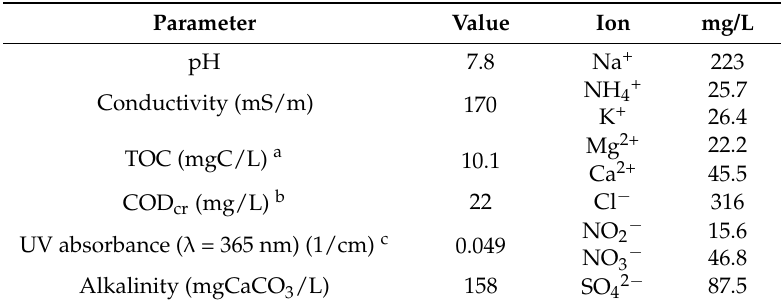
Table 1. Water quality analysis of the reverse osmosis